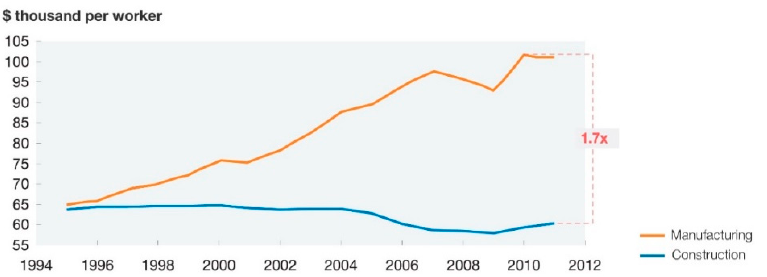
Figure 1. Construction productivity has been flat for decades, according to McKinsey research. In manufacturing, by contrast, productivity has nearly doubled over the same period, and continuous improvement has been the